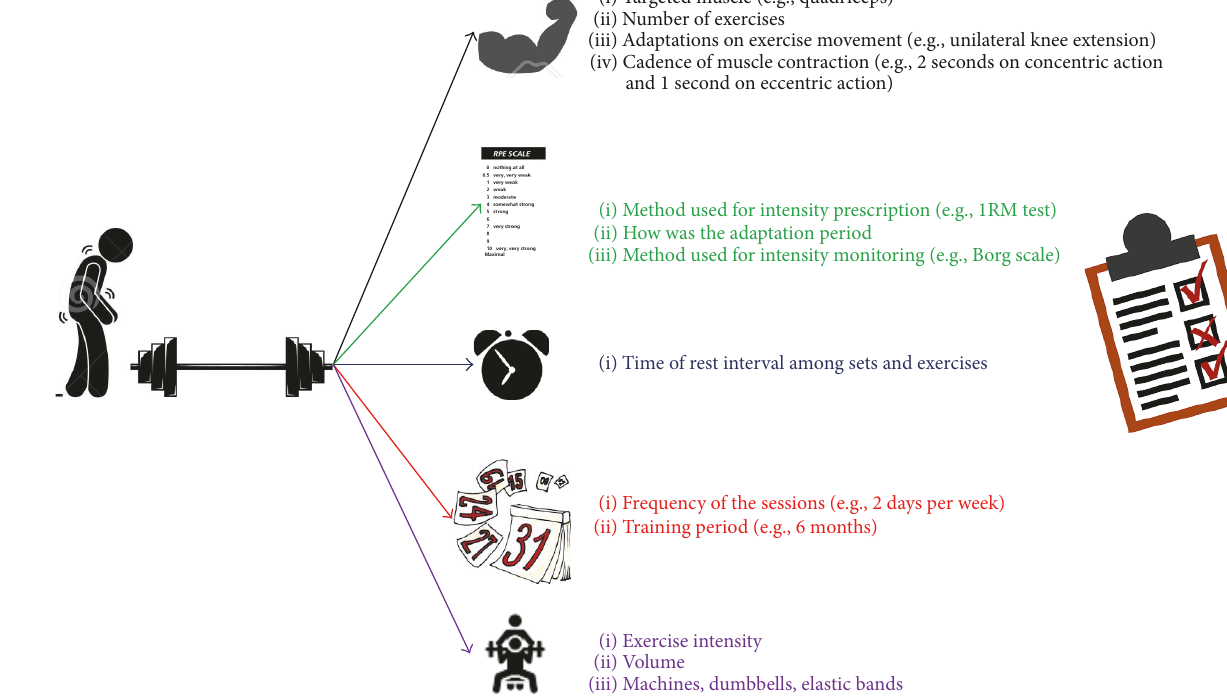
Figure 1: Minimal amount of information that should be described in experiments that use RT programs.